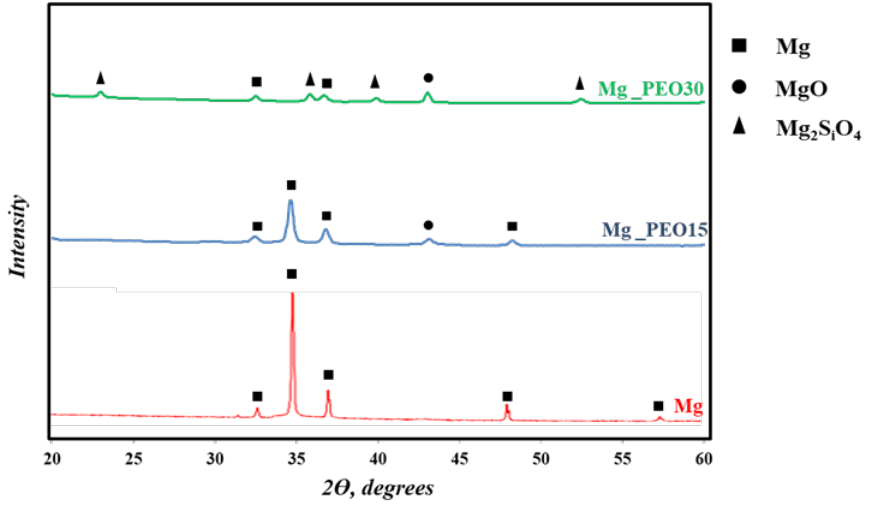
Figure 6. XRD pattern of the PEO coatings in comparison to the AZ31 magnesium substrate.